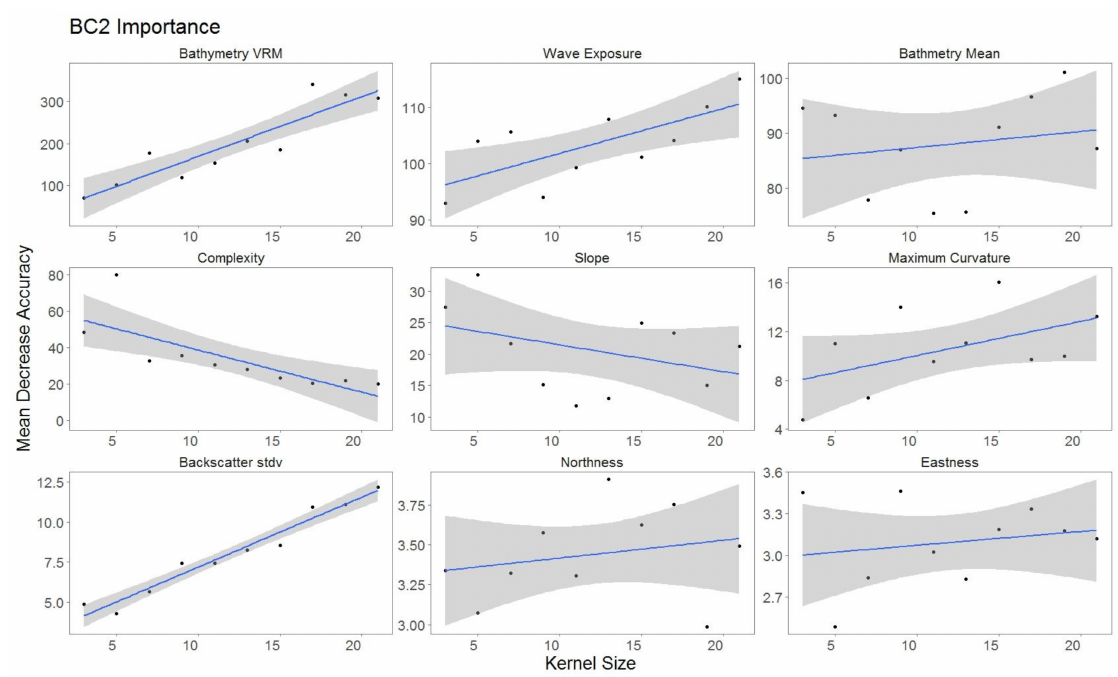
Figure 6. Variable importance for BC2, for variables retained. Sorted by derivatives in order of importance. Generalized linear model (GLM) trend represented in blue. Gray area represents 95% confidence interval for predictions.